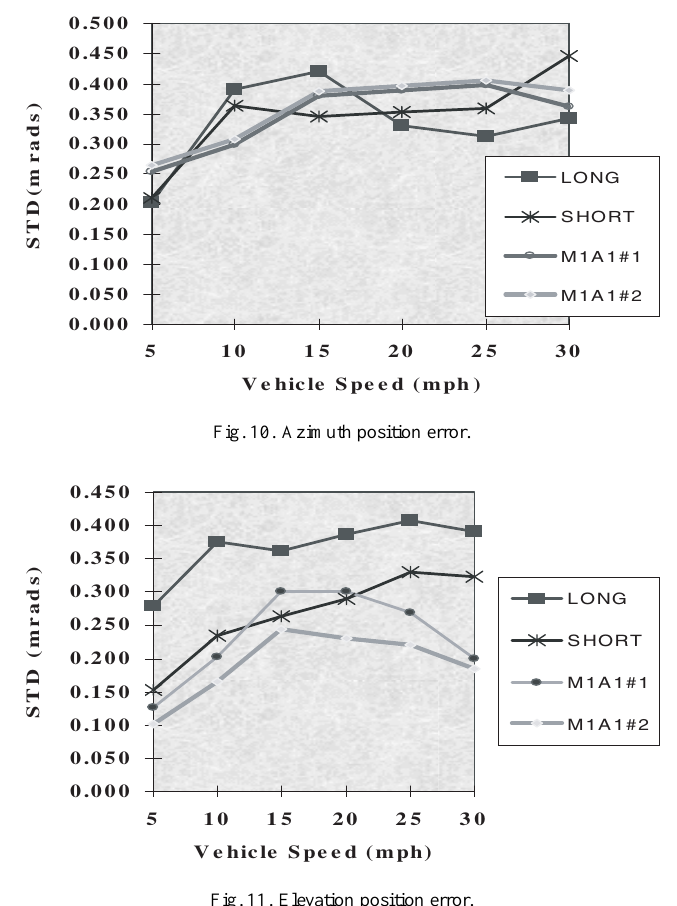
Fig. 11. Elevation position